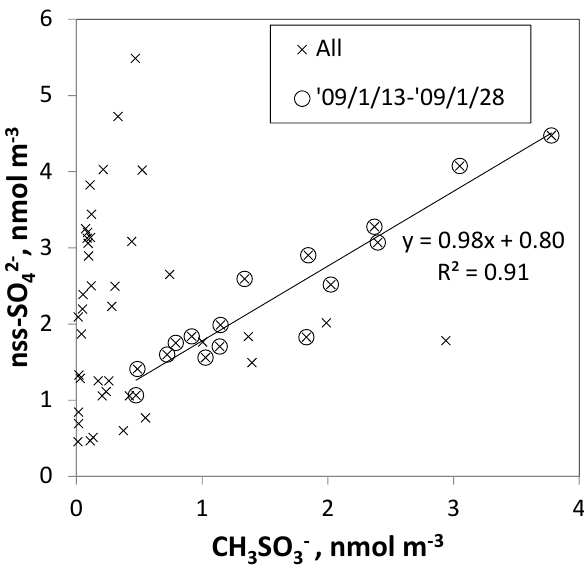
Figure 13. Scatterplot of CH 3 SO − aerosols. Crosses and circled crosses respectively represent data for all samples and for samples collected at sites of latitudes higher than 60 ◦ S (from 09 (cid:48) 1 / 13 to 09 (cid:48) 1 / 28). The fitting line is linearized for circled